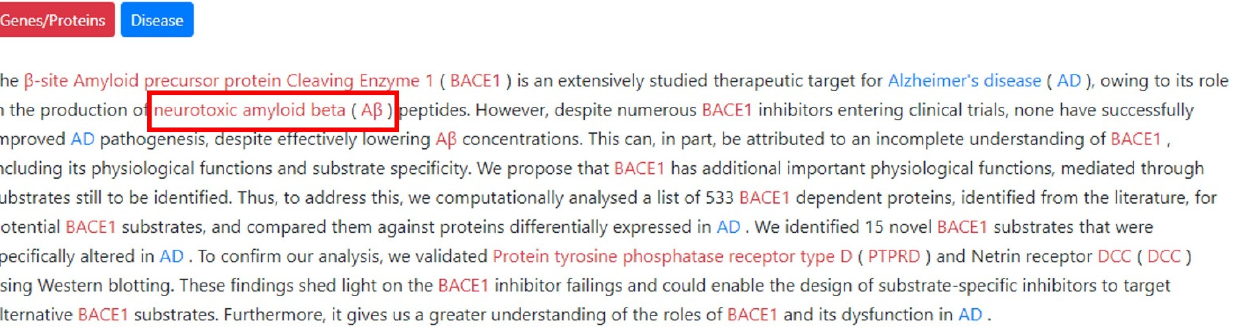
Figure 10. Web service result obtained by applying the retrained model.